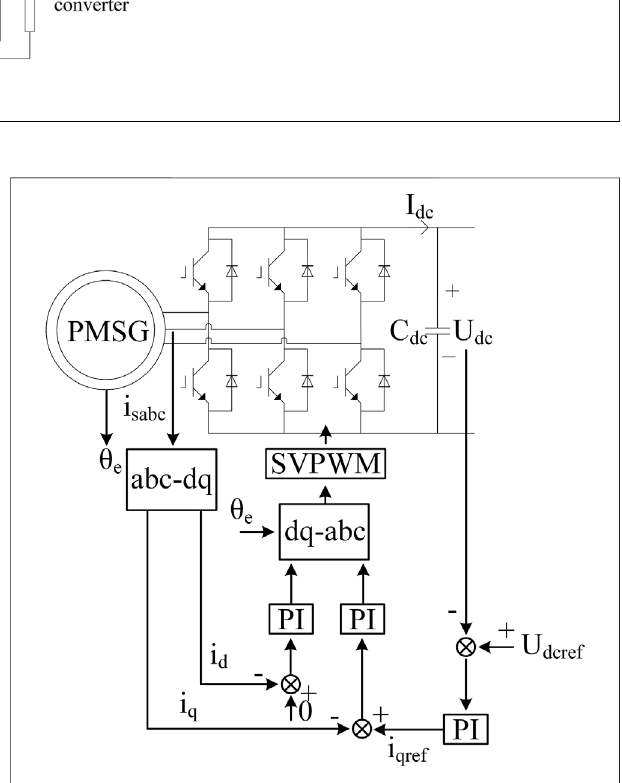
FIGURE 2 | Control strategy of the generator-side